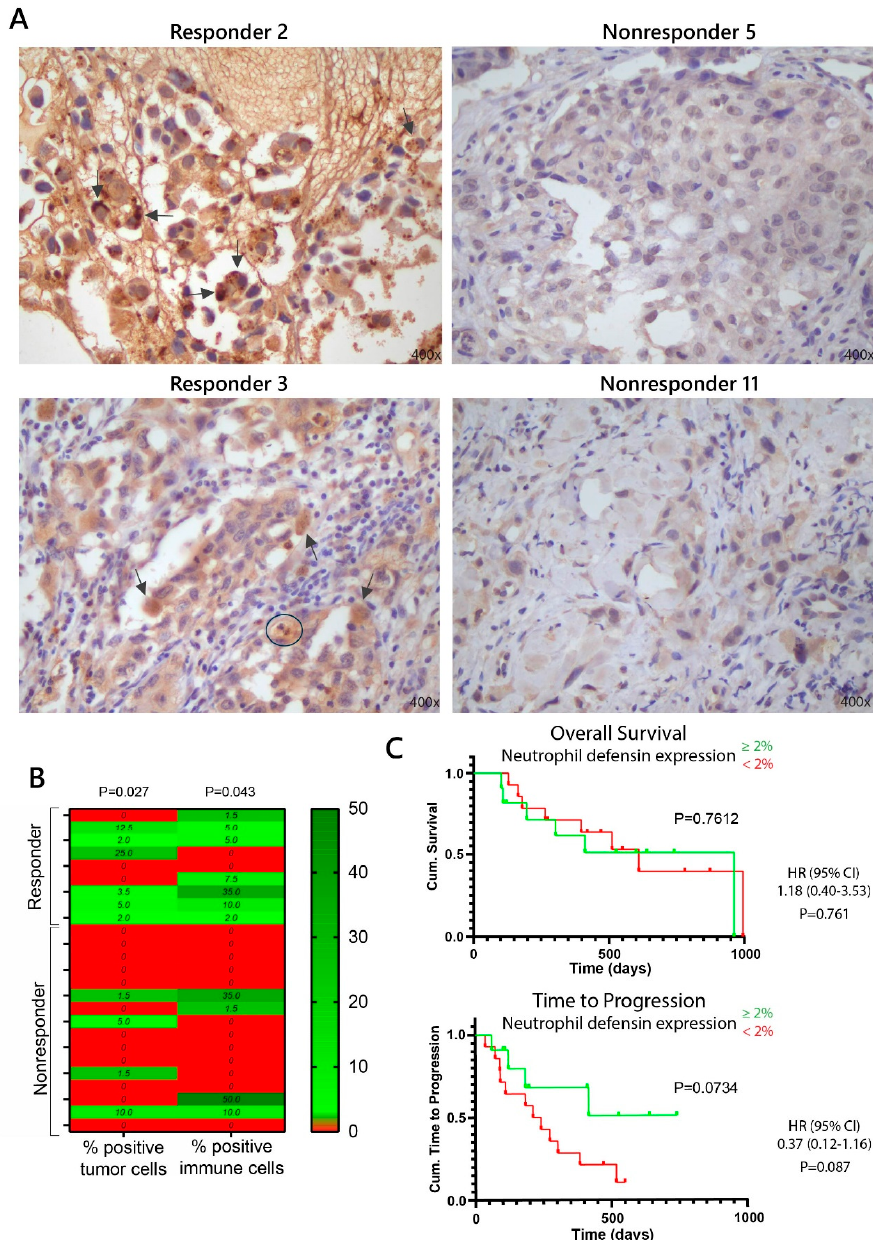
Figure 5. Immunohistochemistry analyses of expression of neutrophil defensin 1/3 on both tumor cells and immune cells in pretreatment tumor biopsies of NSCLC patients who received anti-PD-(L)1 immunotherapy treatment. ( A ) Example of the IHC staining of two different responding patients and two nonresponding patients to immunotherapy treatment. Few examples of neutrophil defensin expression were indicated by the arrows, and an example of expression on neutrophil granulocyte was encircled. Magnification 400×; ( B ) The percentage of neutrophil defensin positive cells for each NSCLC patient individually, determined with IHC. A significant difference between responding and nonresponding patients is observed based upon neutrophil defensin expression on both tumor cells ( p = 0.027) as on immune cells ( p = 0.043), examined with a Mann–Whitney U test; ( C ) Kaplan–Meier survival curves for overall survival (OS) and time to progression (TTP) according to neutrophil defensin expression: NSCLC patients were grouped by ≥ 2% (cut-o ff 2% determined by receiver operating characteristic (ROC) analysis) neutrophil defensin expression on tumor cells and / or immune cells (green) and < 2% neutrophil defensin expression (red). Significance was determined using the log-rank test. Hazard ratio ( + 95% CI) is determined using Cox